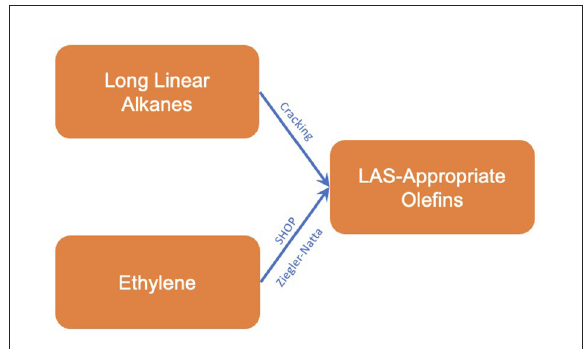
FIGURE6 Tree diagram for the production of LAS-appropriate olefins from first-degree platform